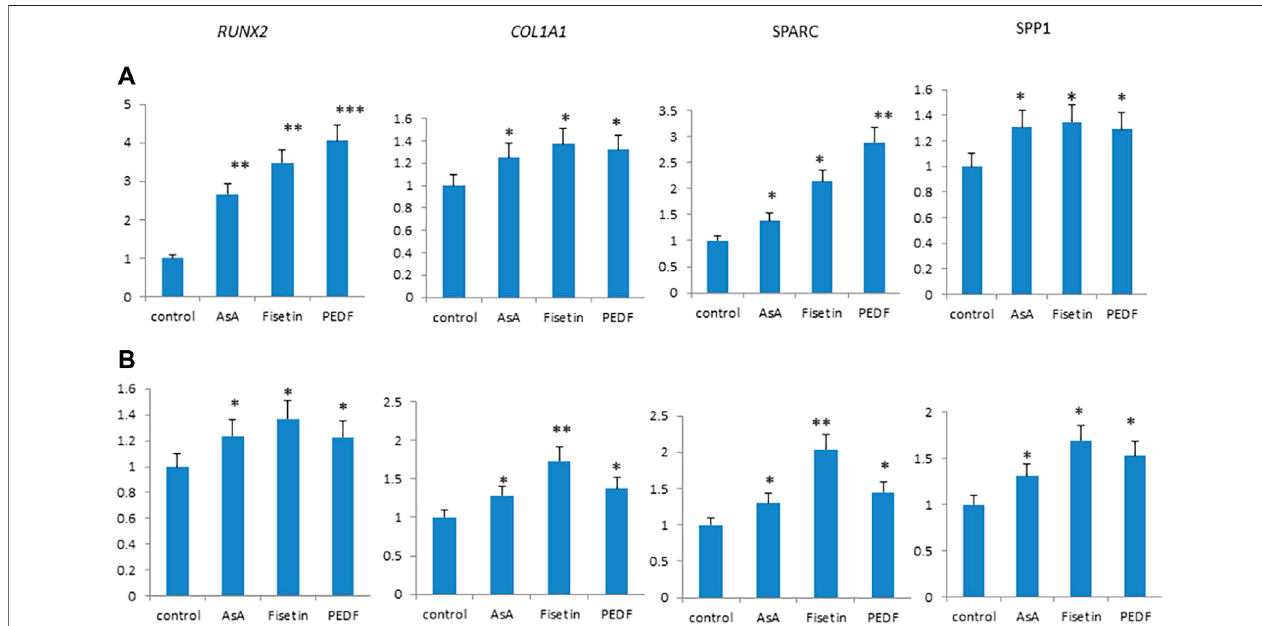
FIGURE 4 | Fisetin, PEDF and AsA were able to upregulate osteogenic genes expression in MSCs after 7 (A) and 14 (B) days of supplementation. * p < 0.05; ** p < 0.01; *** p < 0.005.